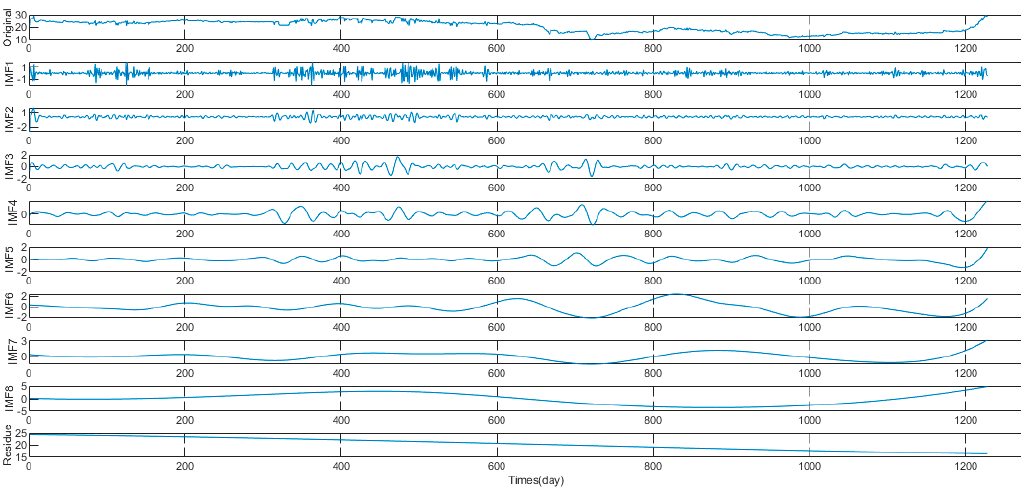
Figure 7. The results of the Hubei carbon price, decomposed by EEMD.